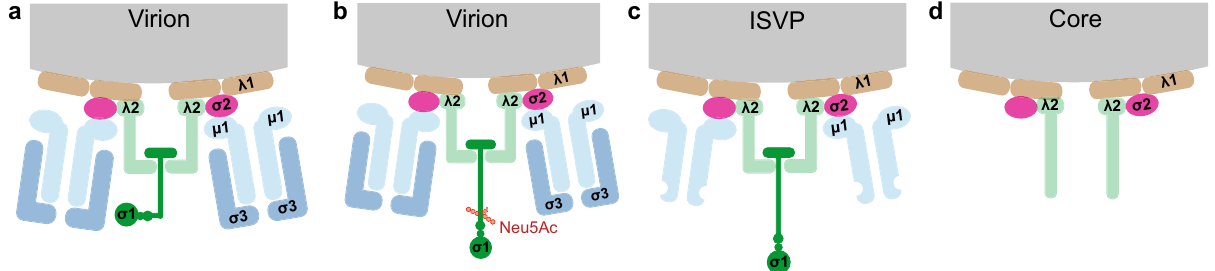
Fig. 1 Schematic of capsid composition of reovirus particles. a – d Diagrams of cross-sections of reovirus virions, infectious subvirion particles (ISVPs), and cores. Schematics depict the arrangement and conformation of structural proteins in the double-layered shells of the virions in the absence ( a ) and presence ( b ) of Neu5Ac (triggering a conformational change of σ 1); removal of σ 3, cleavage of μ 1, and rearrangement of σ 1 in ISVPs ( c ); and removal of μ 1 fragments, loss of σ 1, and opening of the λ 2 turret in cores ( d